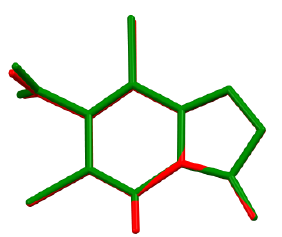
Figure 5. Overlay structures of 1a (green) and 1b (red).